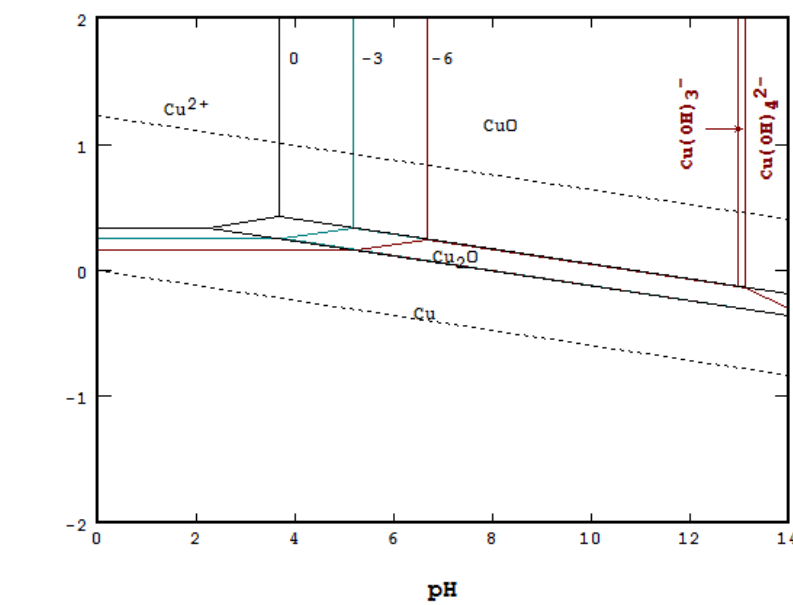
Figure 9. Eh-pH of Cu-water constructed by the line method where three concentrations in log scale are plotted. Data taken from NBS [1].